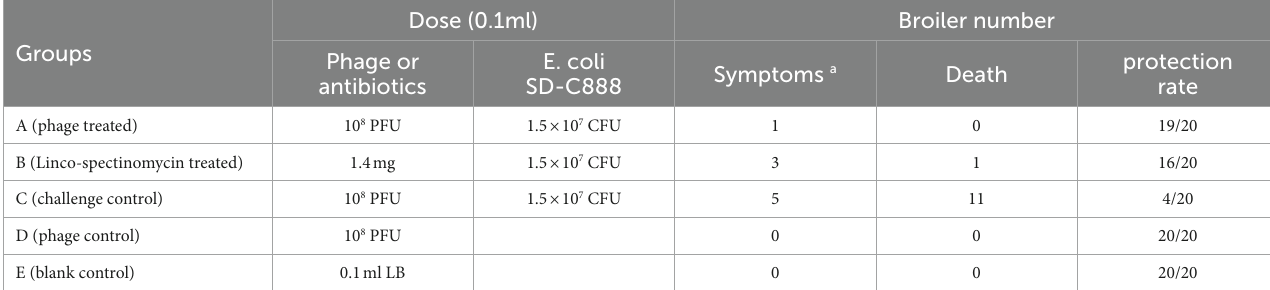
TABLE 2 Protection of phage CE1 on challenged broilers.